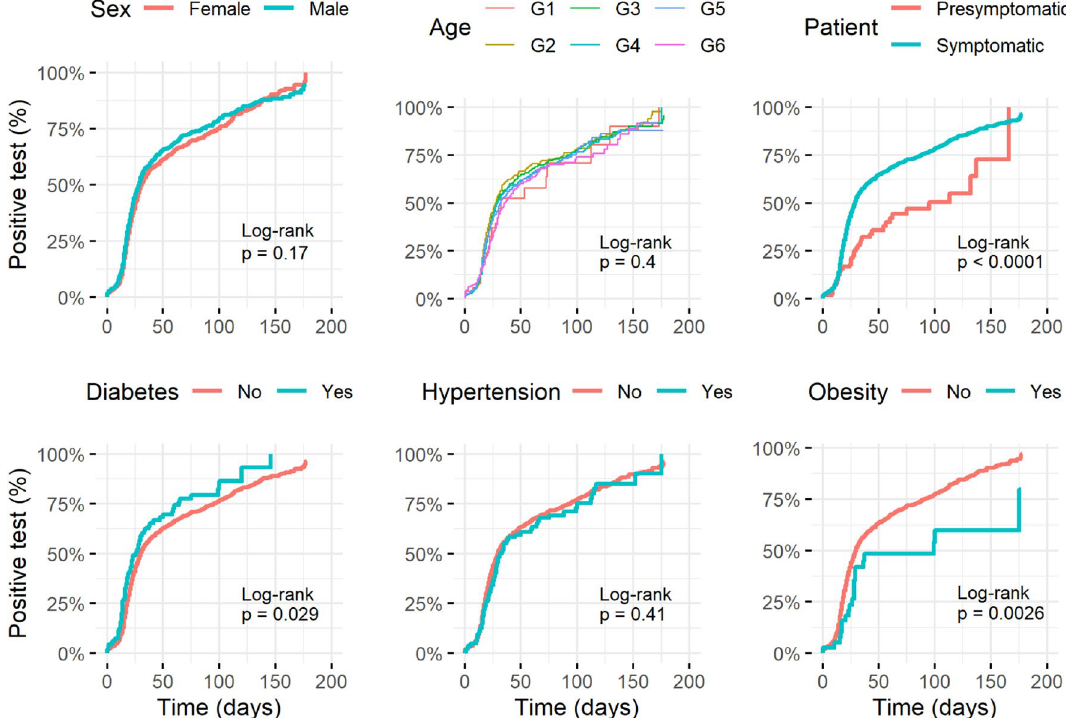
Figure 2. Seroconversion dynamic according to clinical characteristics in patients with COVID-19. Kaplan– Meier curves from the time COVID-19 was diagnosed by PCR test to a positive anti-SARS-CoV-2 antibodies result. The curves present the cumulative incidence of positive antibodies test in 1655 individuals diagnosed with COVID-19 and have a specific characteristic (blue) versus those who did not have the characteristic of interest (red) in time. Only sex and age Kaplan–Meier curves come from crude analysis. Age was included in models by decades: G1: < 20y, G2 = 20–29y, G3 = 30–39y, G4 = 40–49y, G5 = 50–59y, G6: ≥ 60y. Statistical details are in Supplementary Table